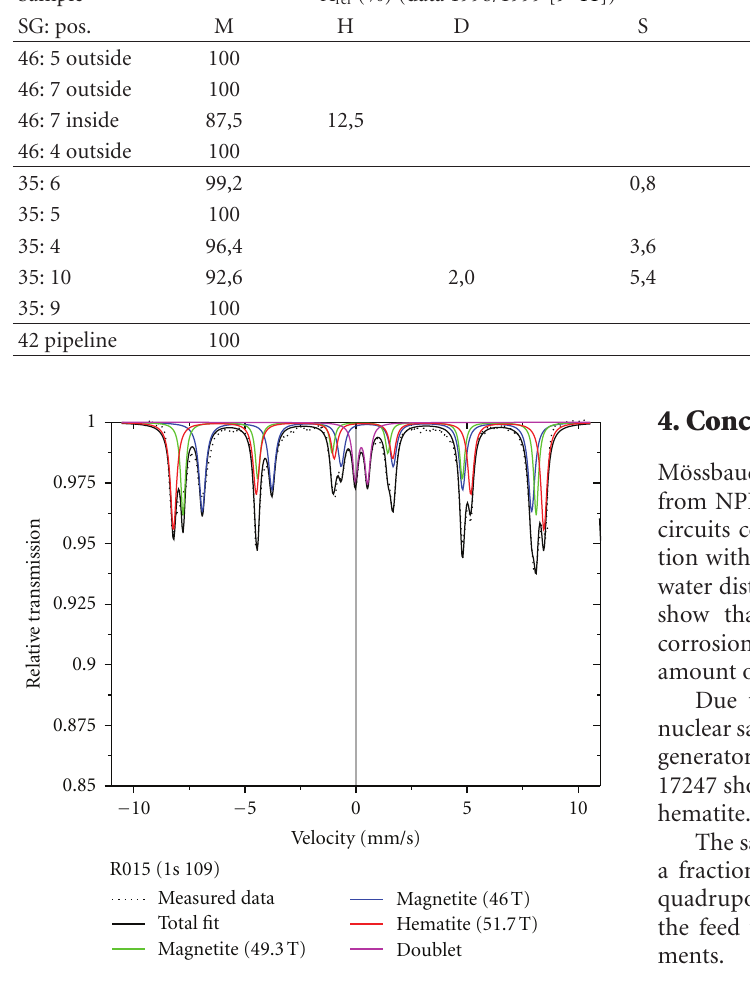
Figure 5: M¨ossbauer spectrum of one of samples taken from the feed water distribution system. The spectrum contains magnetic subspectra (magnetite and hematite) and one paramagnetic sub- spectrum in form of a quadrupole